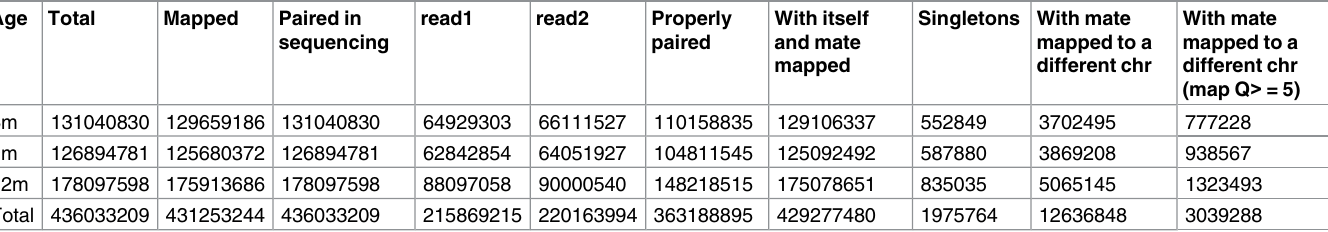
read1 read2 Properly sequencing